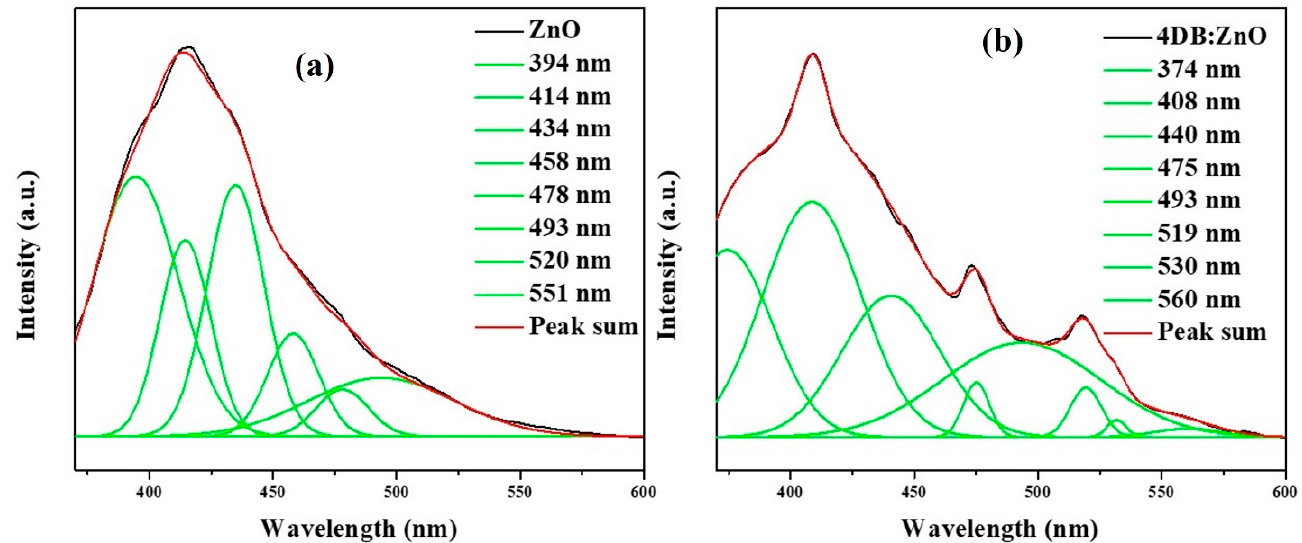
Figure 5. Photoluminescent properties of the ( a ) ZnO NPs and ( b ) 4DB:ZnO NPs.